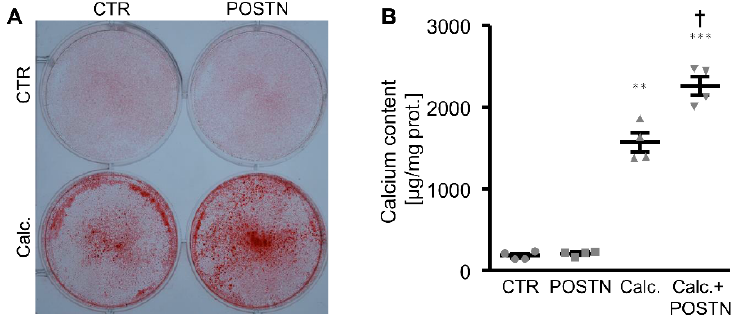
Figure 1. Periostin aggravates phosphate-induced calcification of HAoSMCs. ( A ) Alizarin Red staining in HAoSMCs treated with a control (CTR) or calcification medium (Calc.) without or with additional treatment with recombinant human periostin (POSTN). Calcified areas: red staining. ( B ) Calcium content in HAoSMCs treated with a control (CTR) or calcification medium (Calc.) without or with additional treatment with recombinant human periostin (POSTN). ** p < 0.01; *** p < 0.001 (significant difference versus CTR group); † p < 0.05 (significant difference versus Calc.